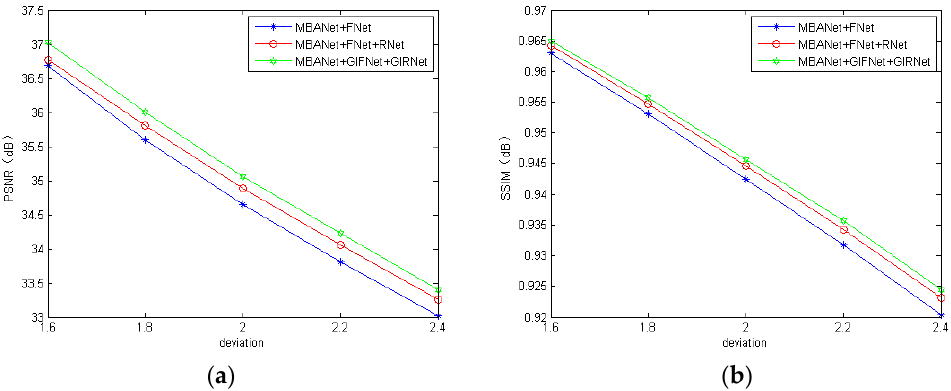
Figure 8. The PSNR and SSIM of different network models: ( a ) PSNR; ( b ) SSIM.